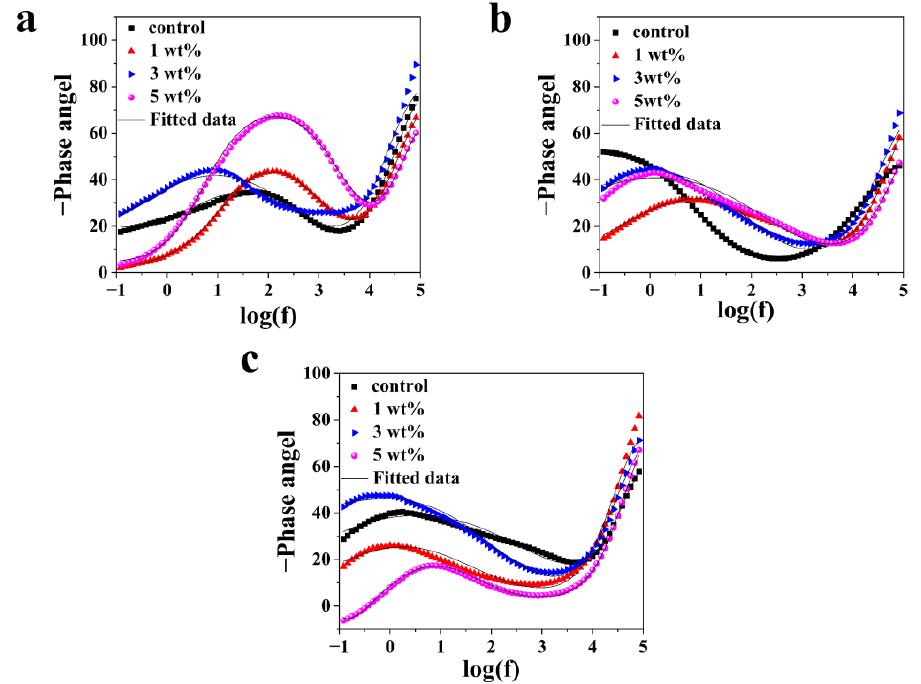
Figure 11. Bode plots of different coatings immersed in 3.5 wt% NaCl solution for ( a ) 48 h, ( b ) 144 h, ( c ) 840 h.